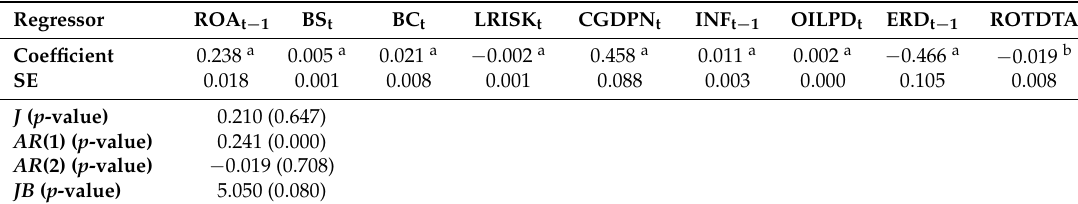
Table 6. GMM estimation results with